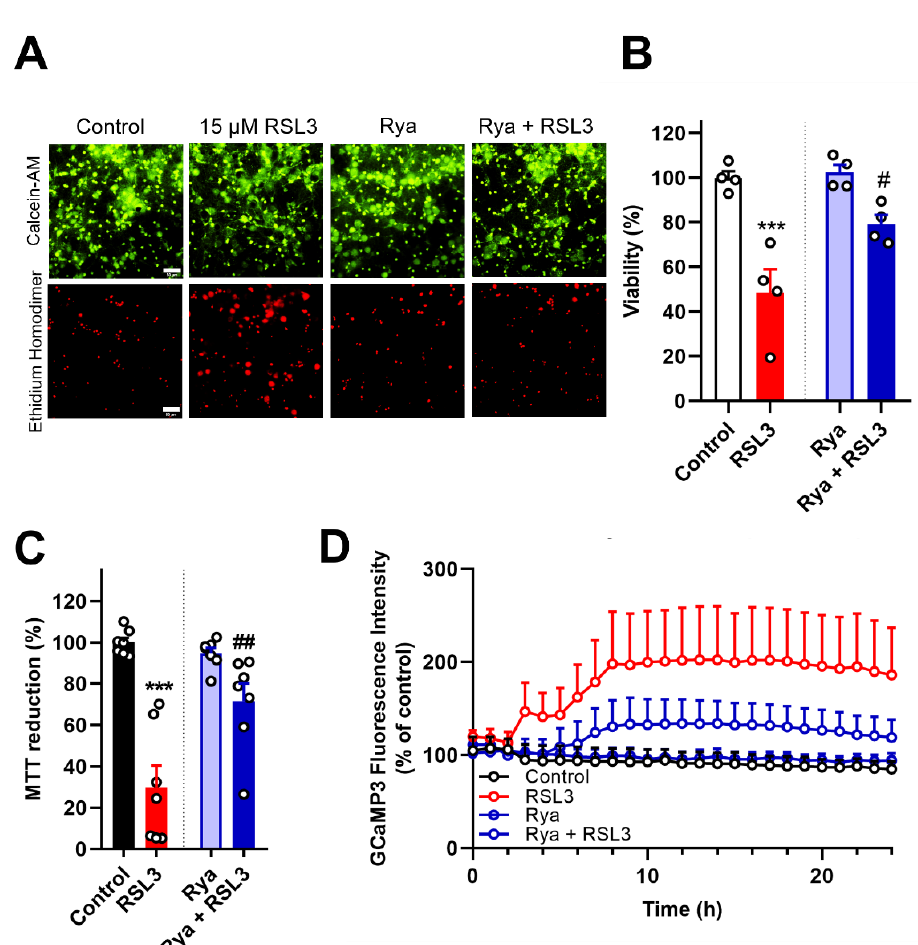
Figure 5. RyR channel inhibition partially protects against ferroptosis and reduces the increase in cytoplasmic [Ca 2+ ] induced by RSL3 treatment. ( A , B ). Primary hippocampal cultures were preincubated for 1 hour with 20 µ M Rya to suppress RyR activity followed by 24-hour incubation with 15 µ M RSL3. Cell viability was assessed by the LIVE/DEAD Viability Cytotoxicity Assay. ( A ). Representative images of primary hippocampal cultures loaded with calcein-AM (green) and stained with ethidium homodimer (red). Scale Bar 50 µ m. ( B ). Quantification of calcein-positive cells, over the sum of calcein- plus ethidium homodimer-positive cells, reveals the partial protective effects of RyR inhibition on RSL3-induced ferroptosis. N = 4 independent experiments, with each condition performed in triplicate. ( C ). Primary hippocampal cultures were preincubated for 1 hour with 20 µ M ryanodine (Rya) followed by 24-hour incubation with 15 µ M RSL3. Metabolic cell viability was assessed by the MTT assay. N = 7 independent experiments; each condition was done in duplicate or triplicate. ( D ). Primary hippocampal cultures infected with rAAV-GCaMP3-NES showed that RSL3 induced time-dependent cytoplasmic [Ca 2+ ] increases, which were reduced by preincubation with 20 µ M Rya. Images were acquired with the IncuCyte S3 live-cell imaging apparatus (Sartorius) using a 20 × objective. Primary hippocampal cultures were from P1 pups. Statistically significant differences among experimental conditions were evaluated by One-Way ANOVA followed by Tukey’s multiple comparisons test. *** p < 0.0002 relative to DMSO (control). # p < 0.0332, ## p < 0.0021 relative to neurons treated with